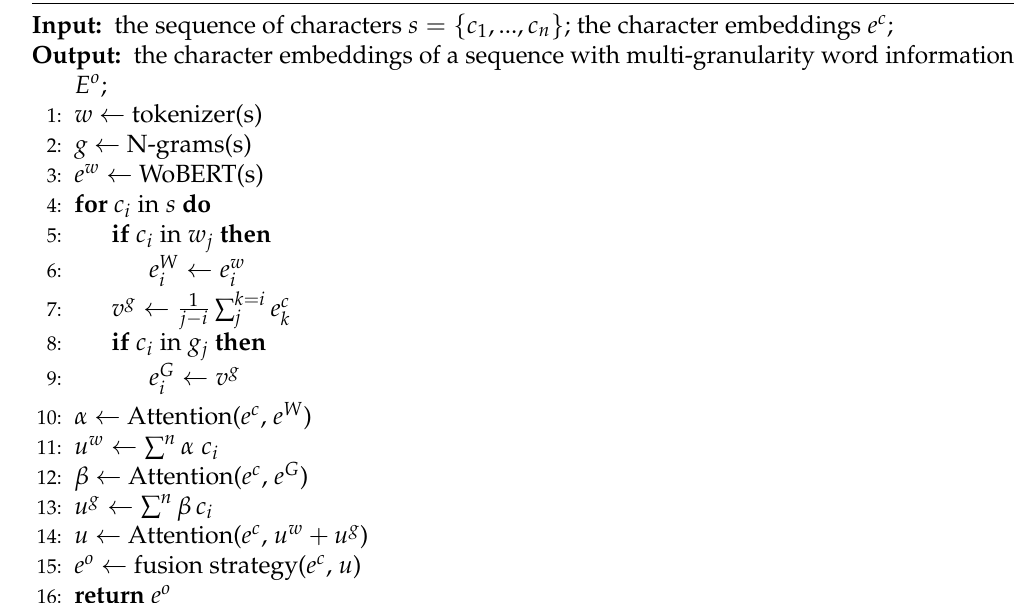
Algorithm 2 Multi-granularity information